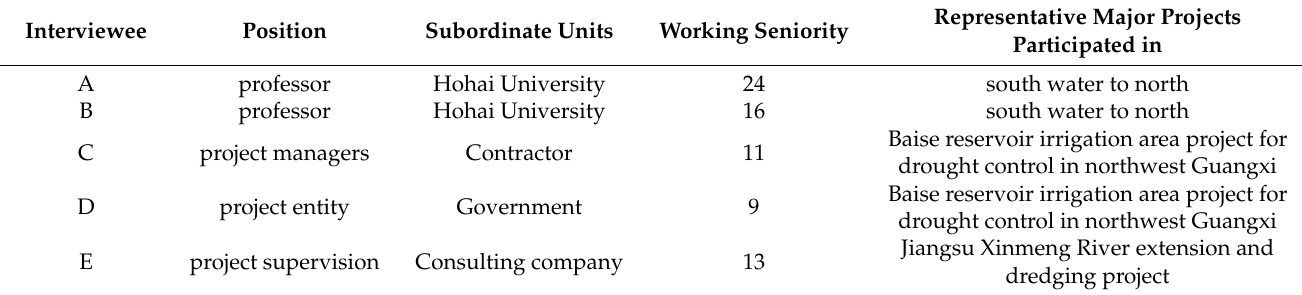
Table 1. Background information of experts